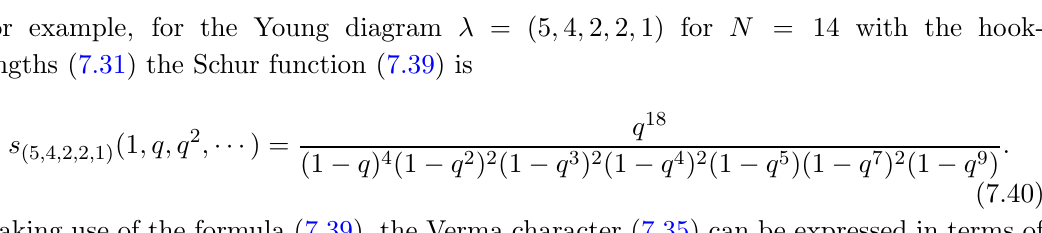
Figure 3 . (a) Young diagram (cid:21) = (4 ; 3 ; 2). (b) Reverse plane partition (cid:25) . (c) Crystal built from (cid:25) with j (cid:25) j = 14